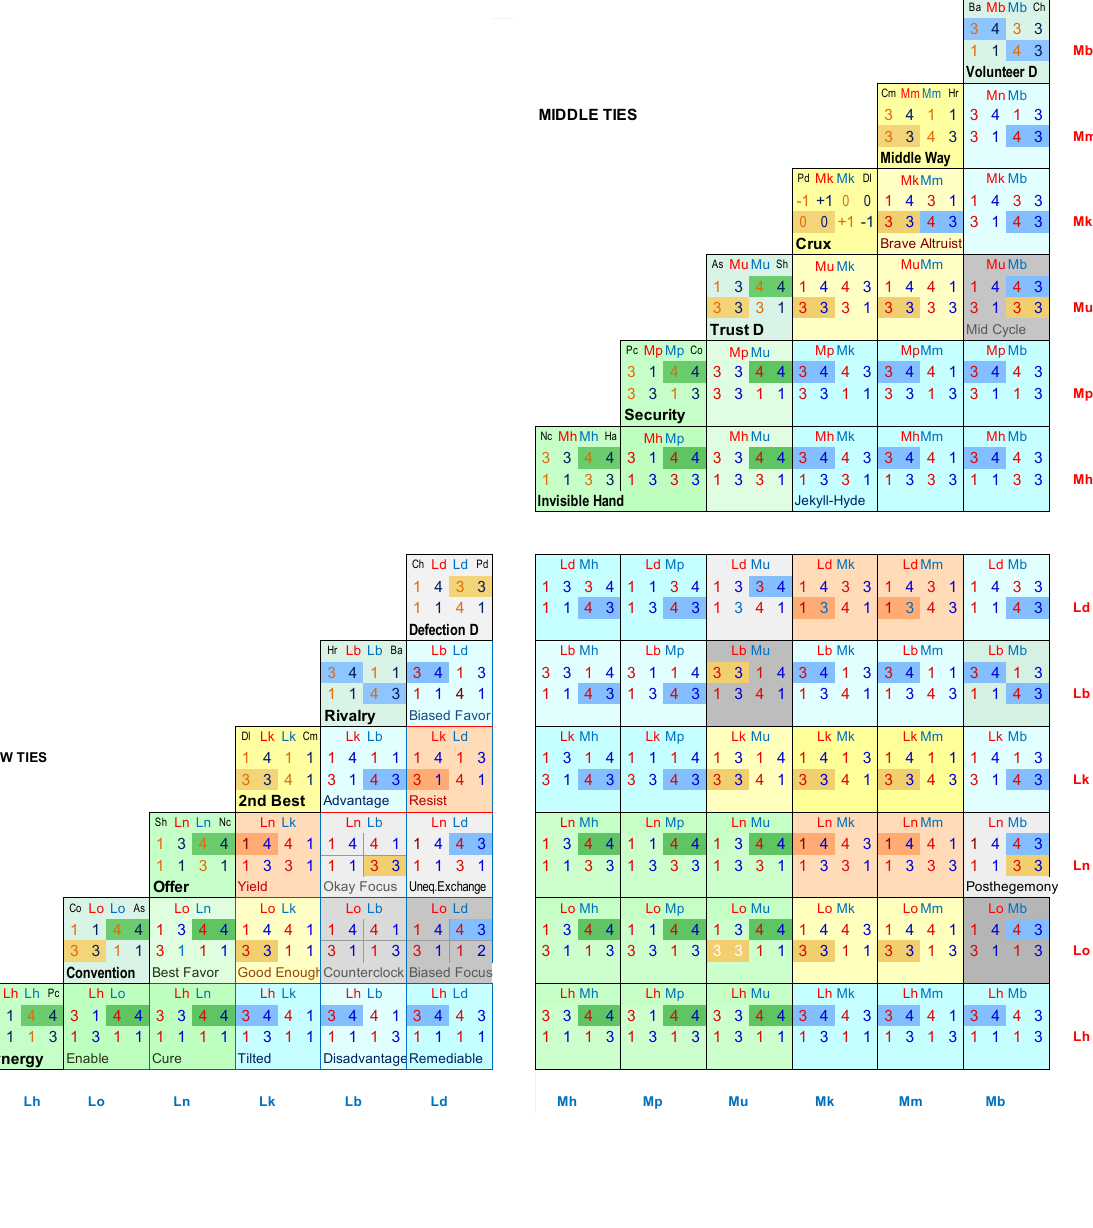
Figure A6. Ordinal games with low and middle ties. Symmetric games are on the diagonal axis. Their payoffs combine to form asymmetric